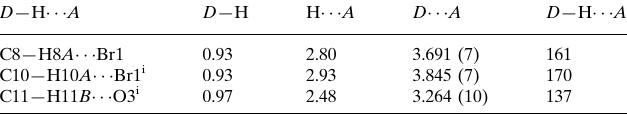
Hydrogen-bond geometry (A˚ , (cid:1)